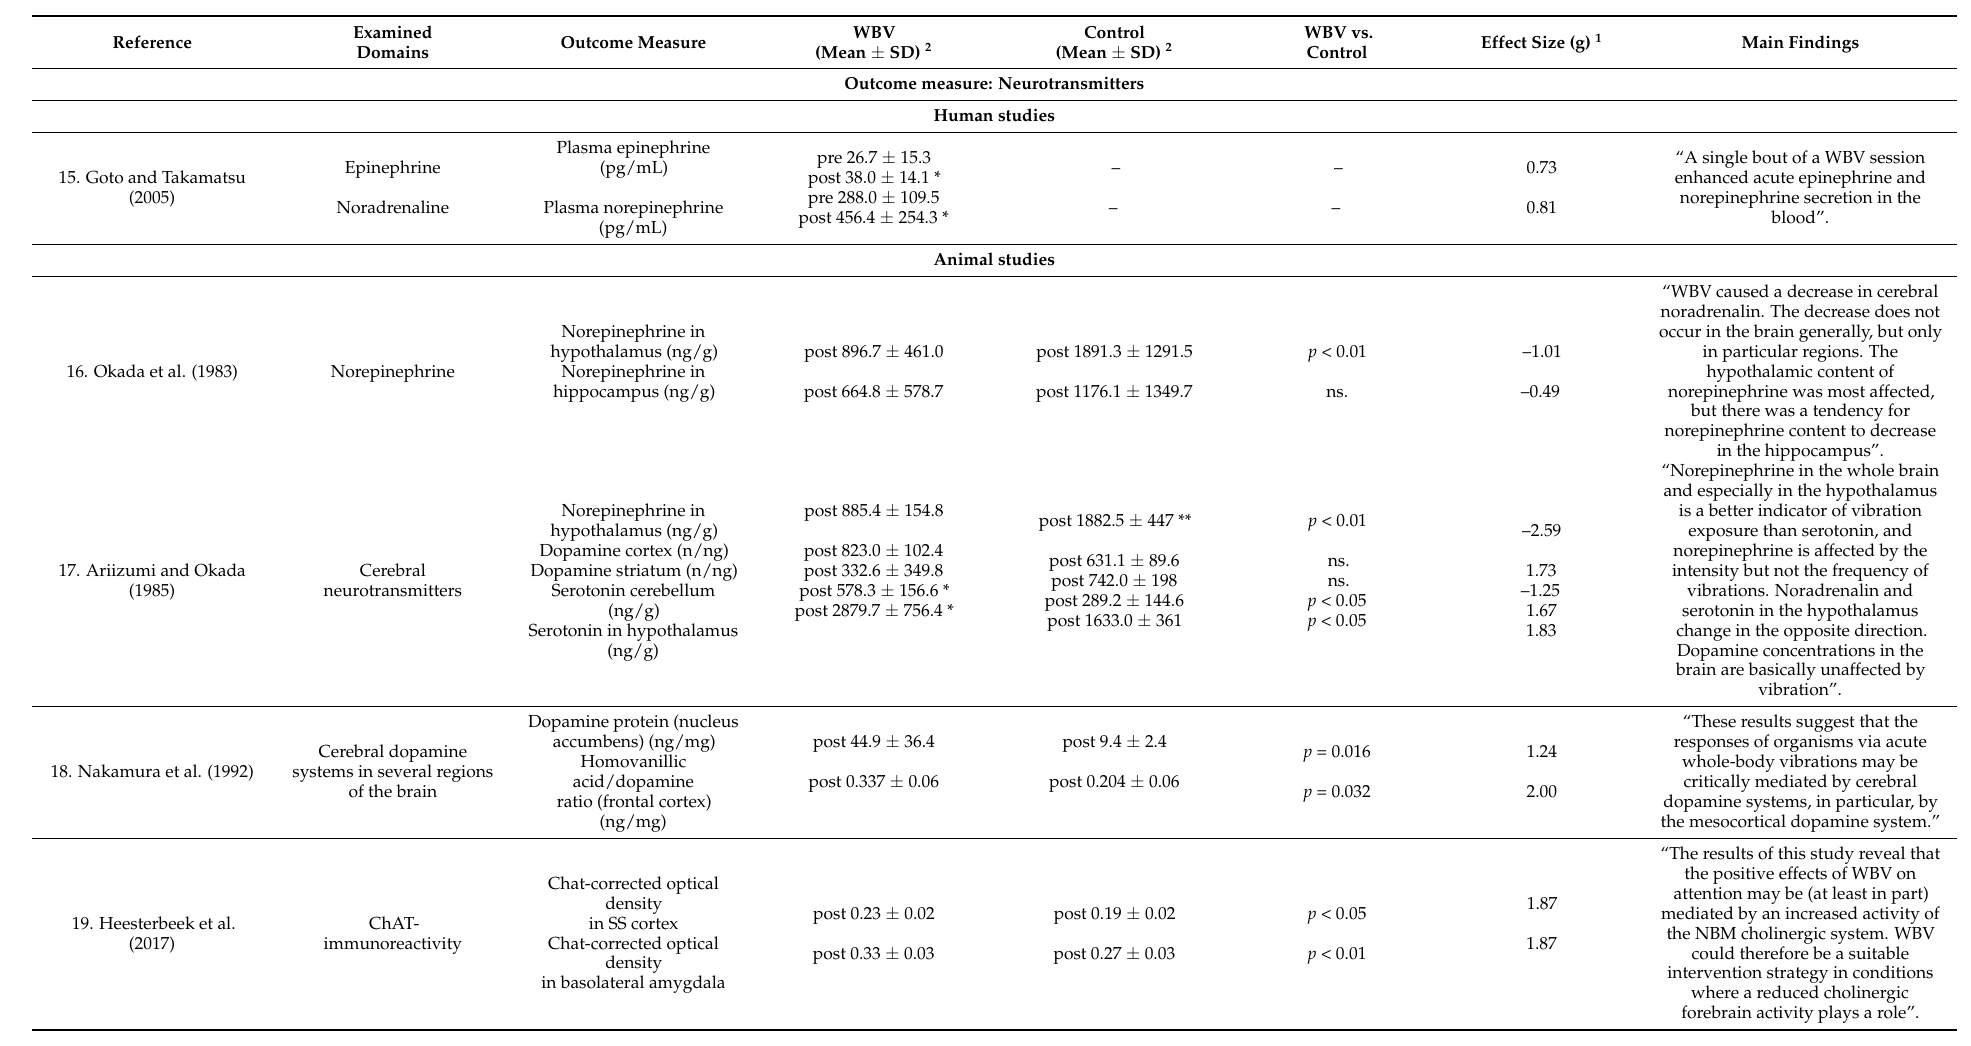
Table 4. Results of studies regarding potential ameliorating effects of WBV on neuropathological mechanisms of